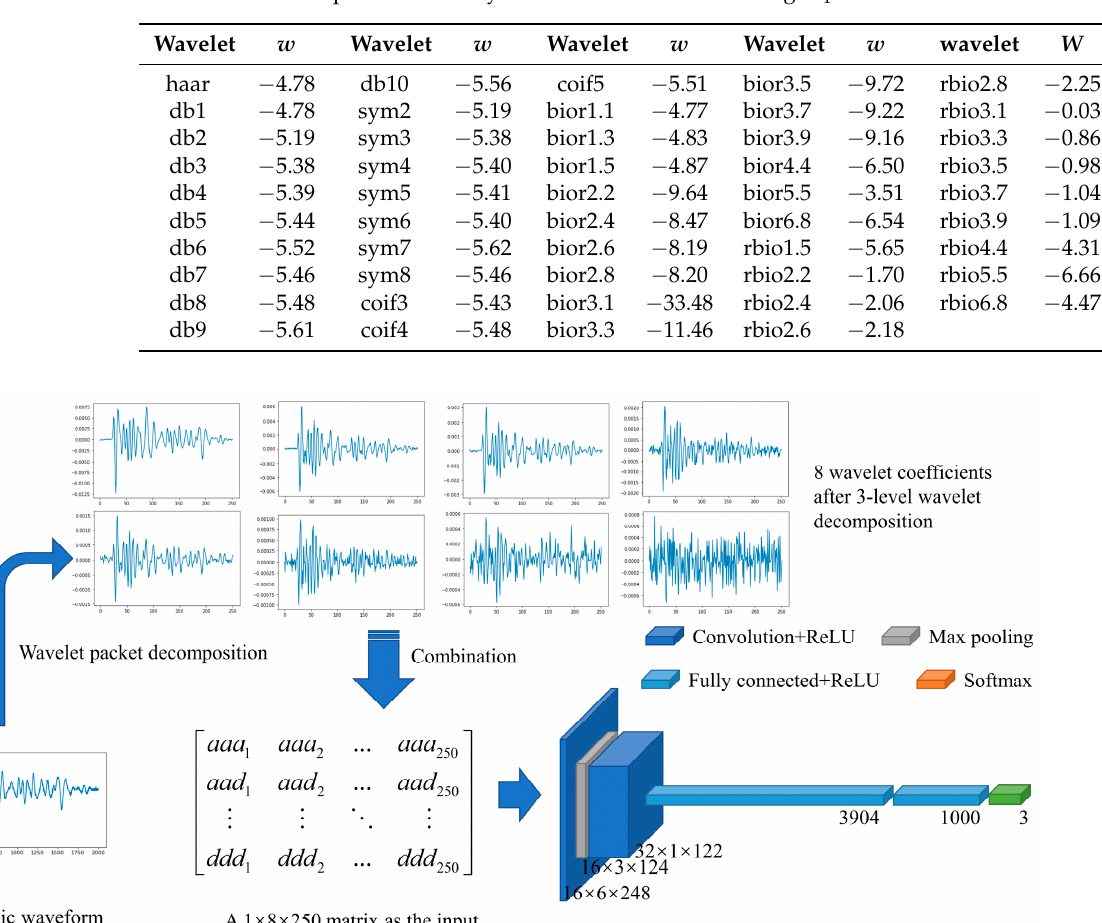
Table 2. The decomposition stability w of each wavelet concerning M 1 .